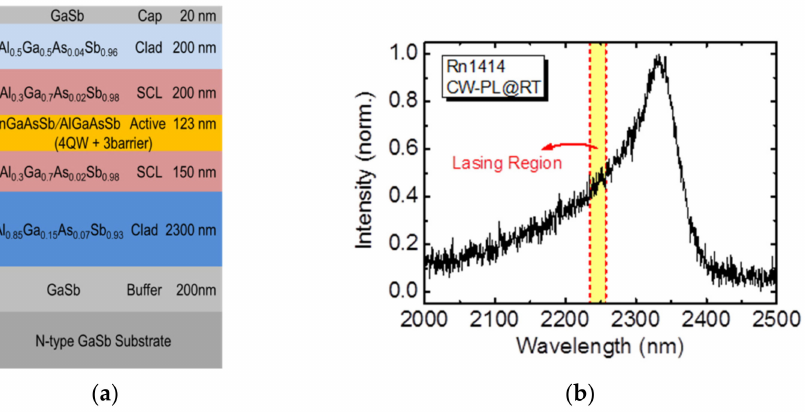
Figure 1. ( a ) The schematic of the epitaxial layer structure and its ( b ) room-temperature photo- luminescence.